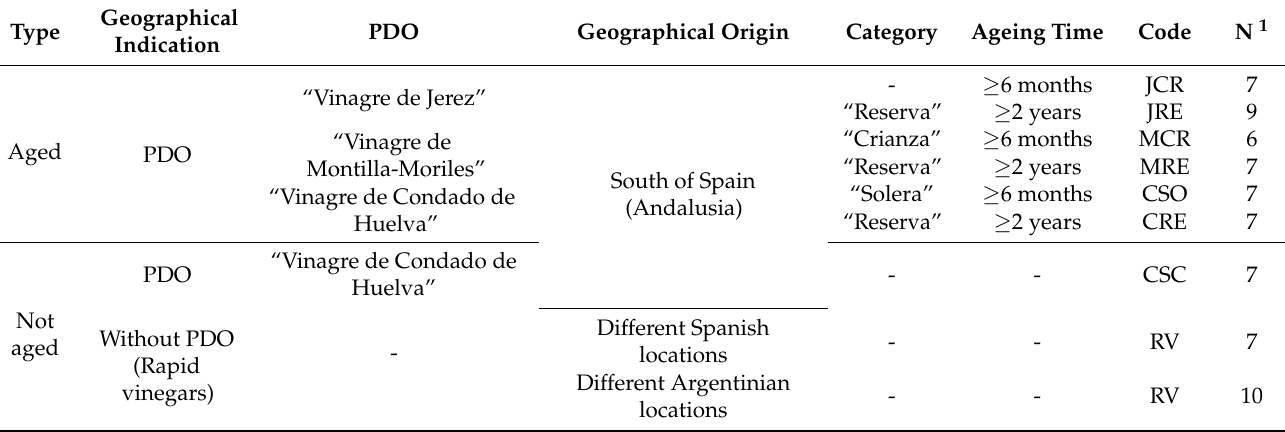
Table 1. Table 1. Information about the samples included in the